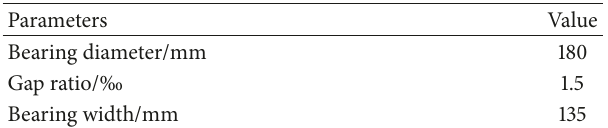
Table 2: The structural and operating parameters of the cylindrical